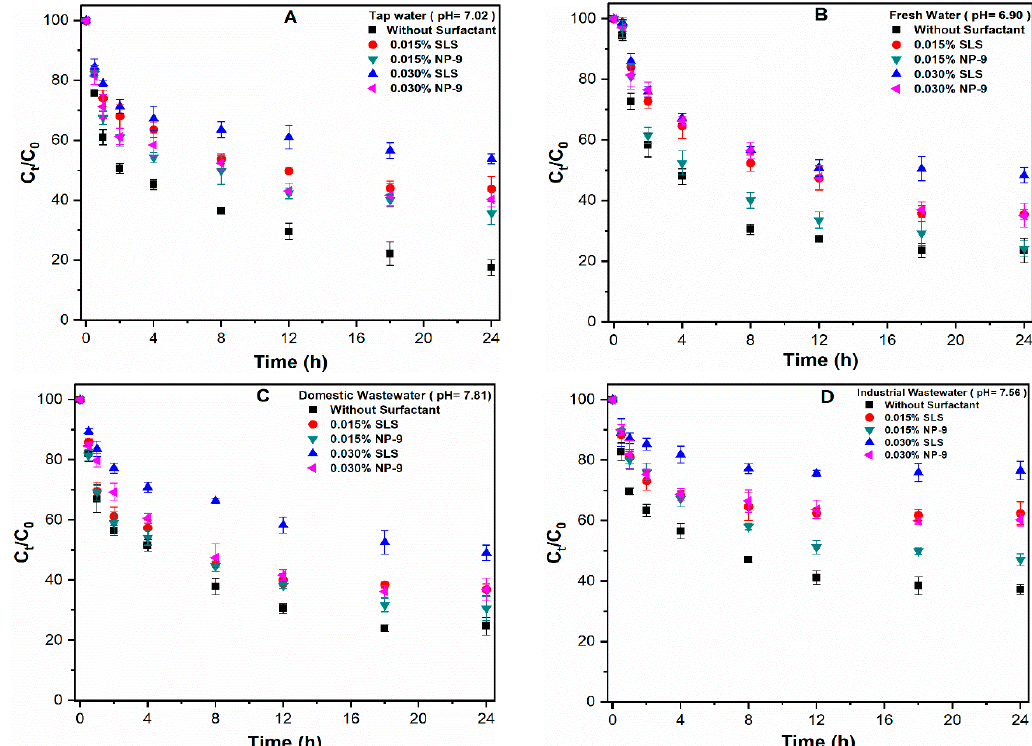
Figure 6. Effects of SLS/NP-9 concentration (0.015 and 0.030%) on the aggregation of CuO NPs in ( A ) tap water; ( B ) fresh water; ( C ) domestic wastewater; and ( D ) industrial wastewater.